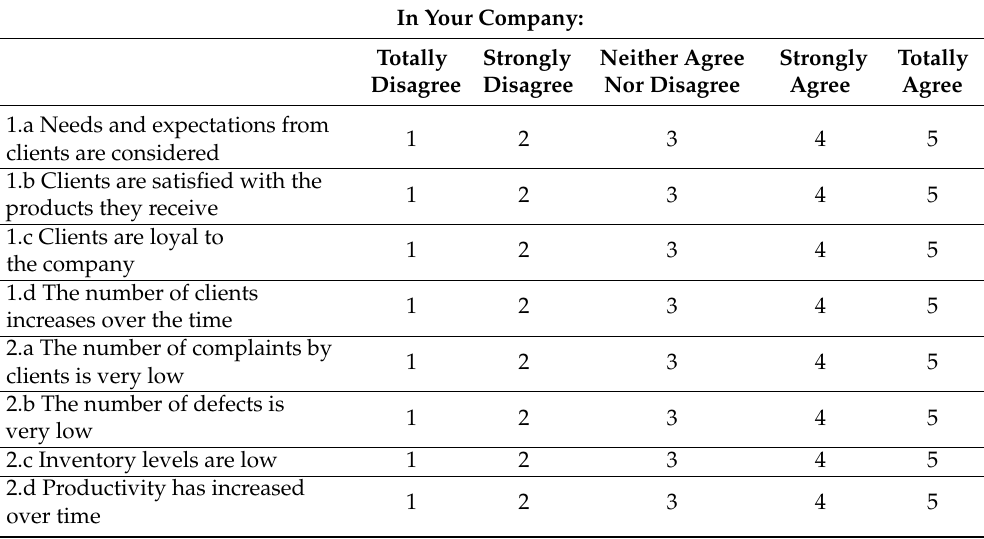
Table 5. Benefits considered in the MCQ when macroergonomic practices are applied. In Your Company: